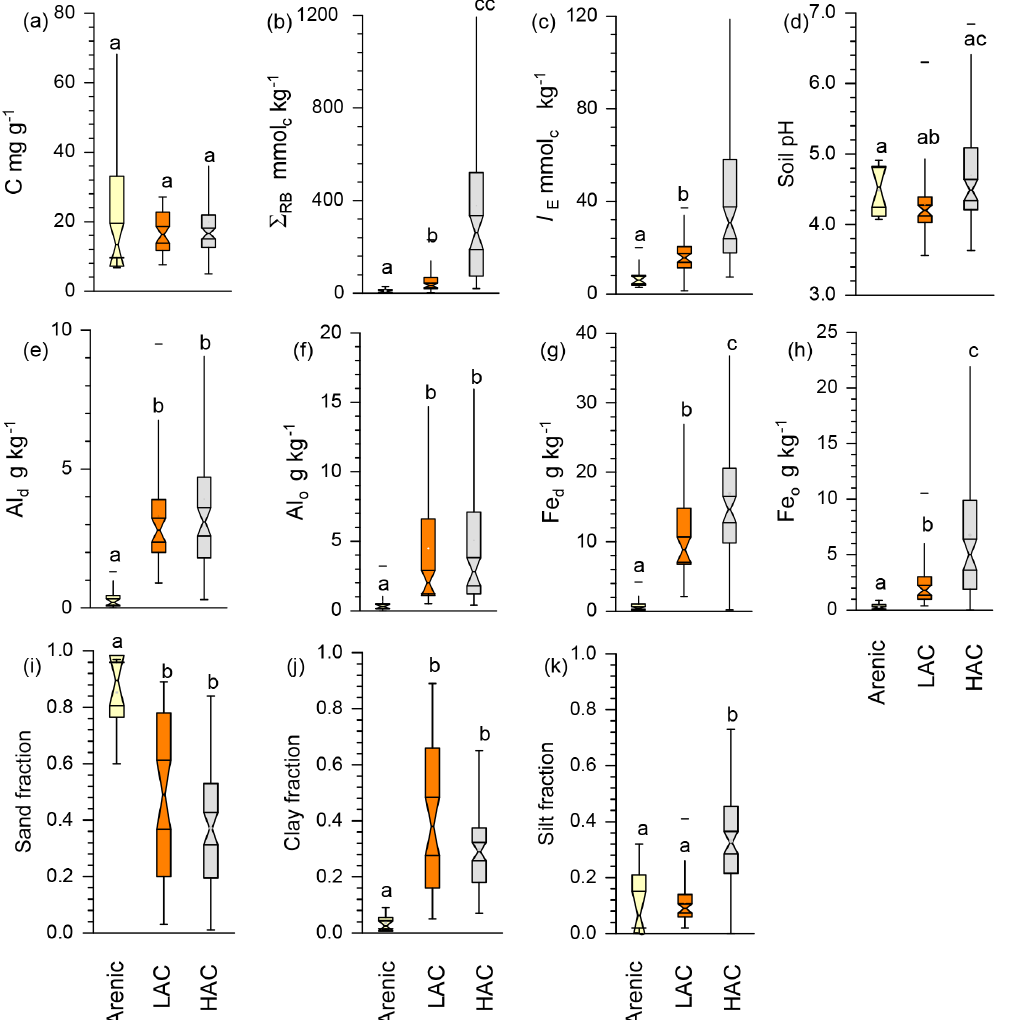
Figure 4. Contrasts between the three soil clusters for selected variables. Statistical differences are given through the non-parametric Kruskal–Wallis test. (a) SOC concentration, (b) total reserve bases, (c) effective cation exchange capacity, (d) soil pH, (e) dithionite–citrate extractable Al, (f) Al o oxalate extractable Al, (g) Fe d dithionite–citrate extractable Fe, (h) oxalate extractable Fe, (i) sand fraction, (j) clay fraction and (k) silt